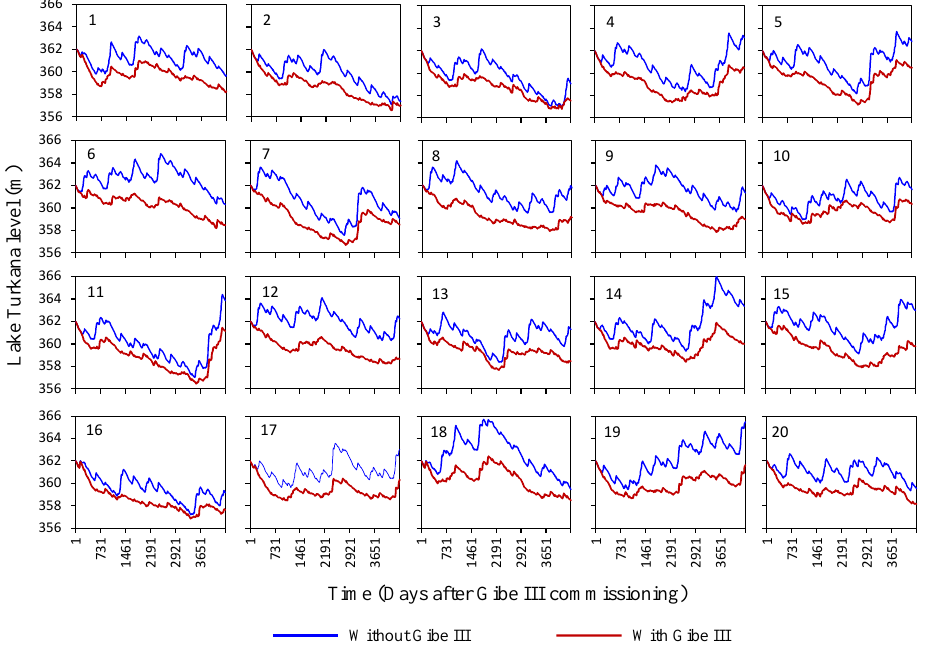
Fig. 4. Impact of the Gibe III dam on Lake Turkana water levels assessed based on 20 rainfall based rainfall scenarios. The blue line shows the lake level fluctuations under each scenario without the Gibe III dam, and the red line shows the lake level fluctuations after the commissioning of the Gibe III dam.